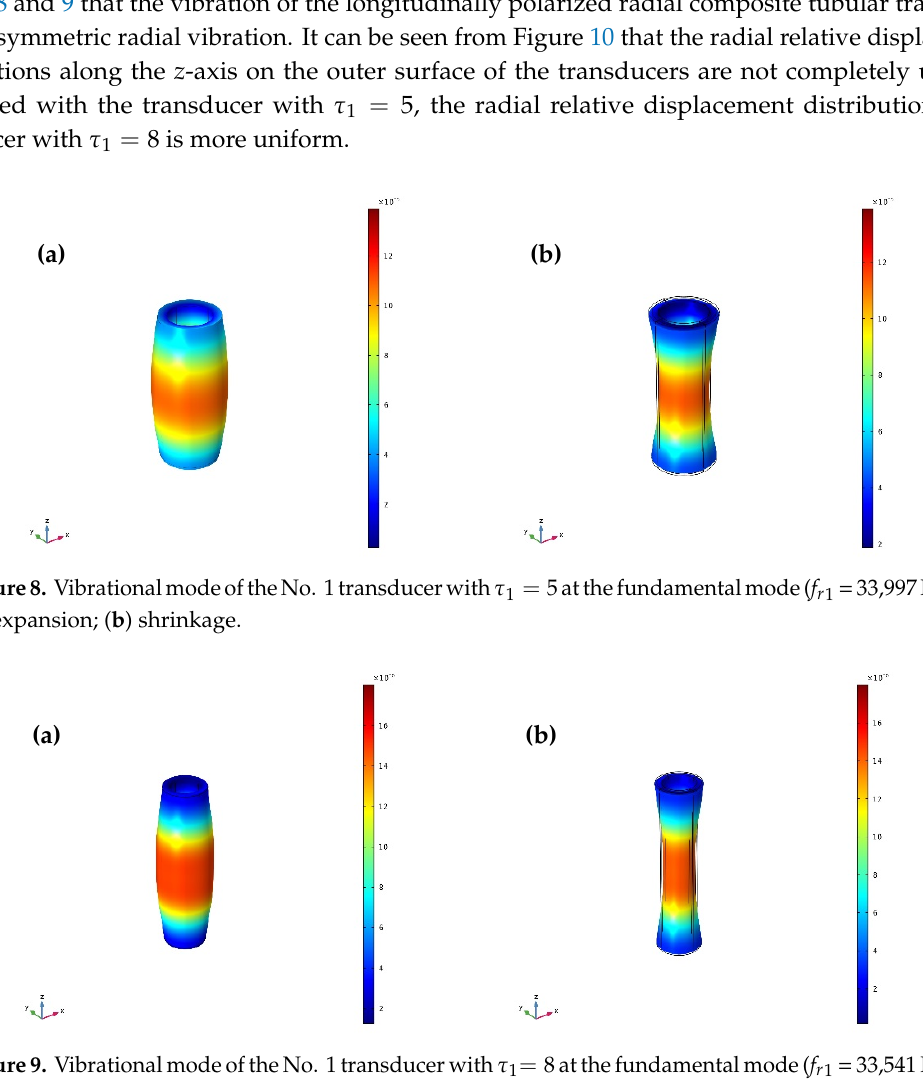
Figure 10. Radial relative displacement distributions of the No. 1 transducer with 1 =5 8 ， τ